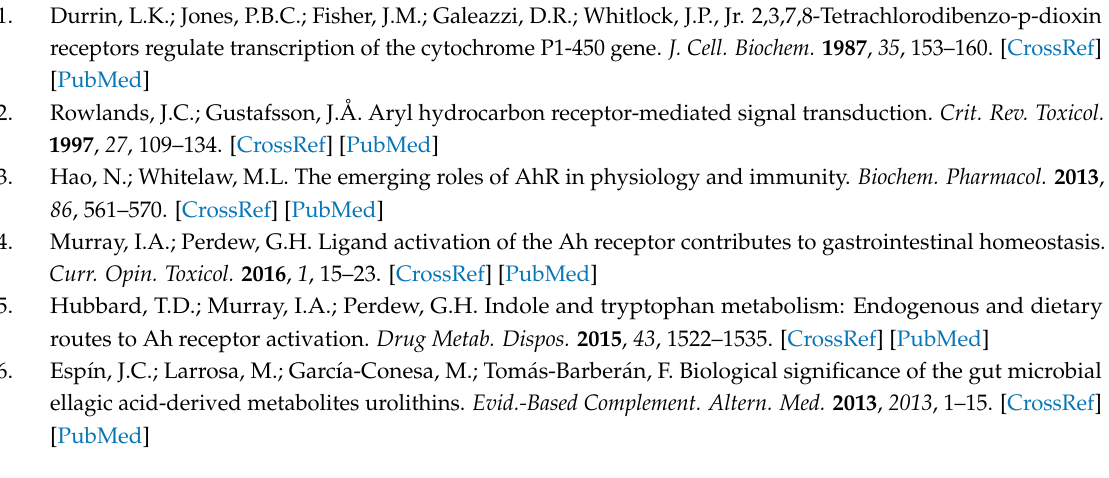
Figure S1: The agonist and antagonist activity of UroA was assessed in Hepa1.1 at higher doses, Figure S2: The agonist activity of UroA was assessed in HepG2 40/6 at higher doses, Figure S3: UroA does not cause cytotoxicity in Hepa1.1, HepG2 (40/6) or Caco-2